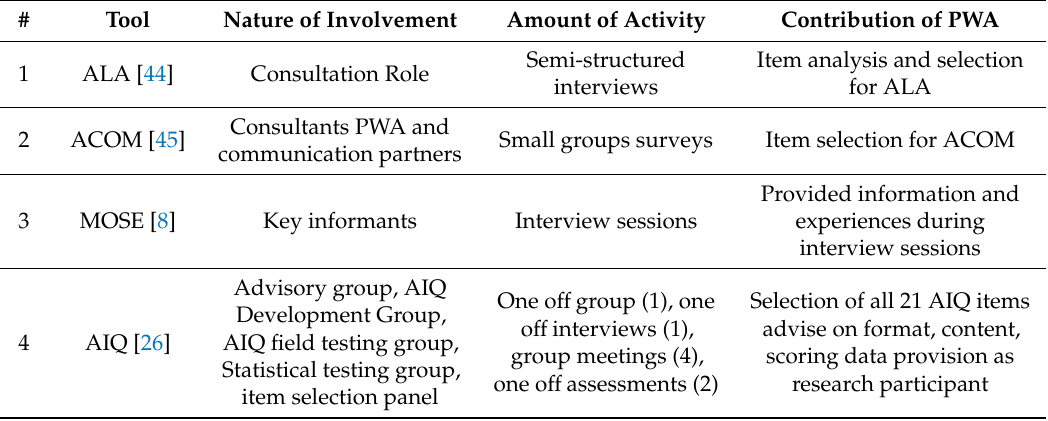
Table 4. The type of involvement of PWA in the creation of the four selected